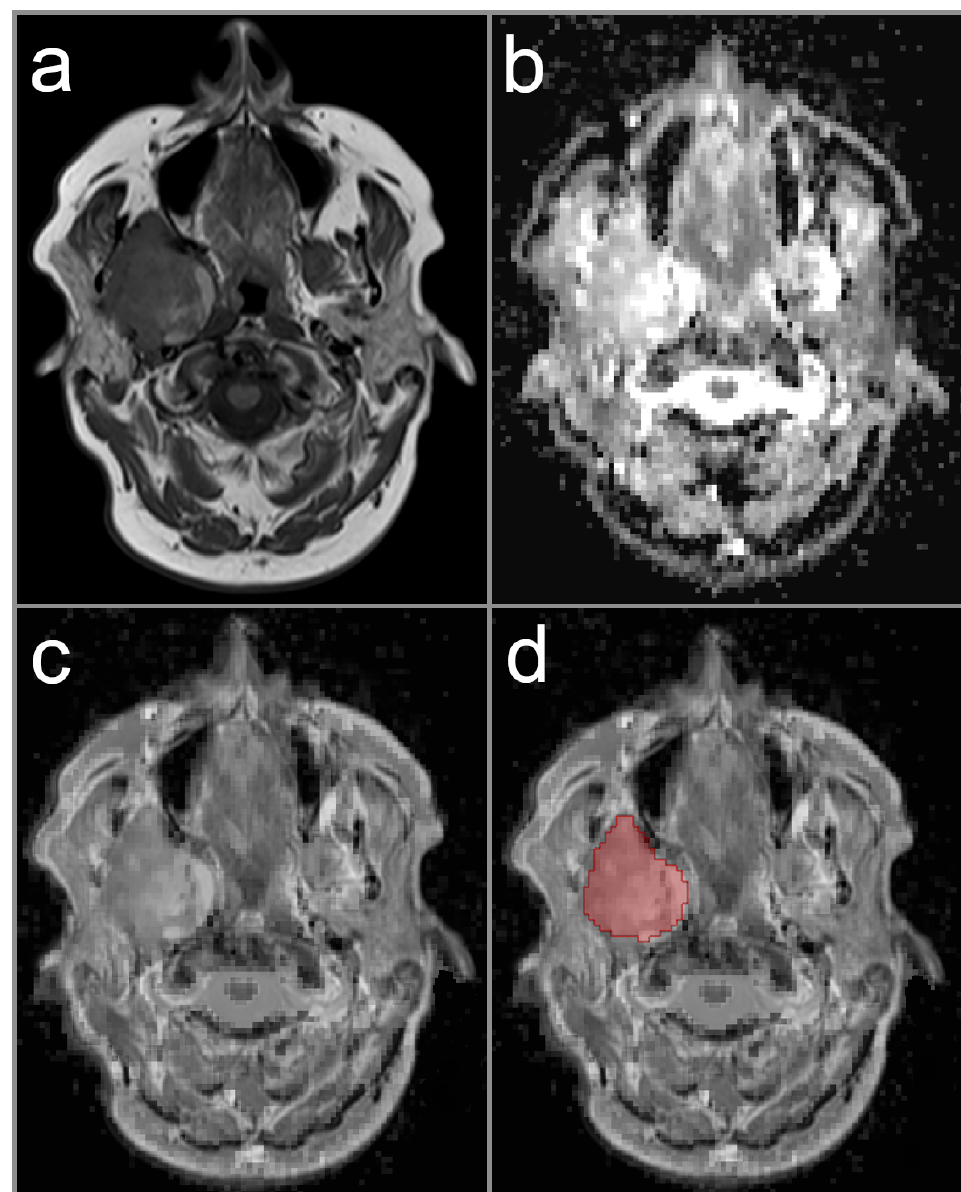
Figure 3. Image illustration a study patient with mucoepidermoid carcinoma in the deep lobe of the right parotid gland (red area indicates lesion on this particular slice). The image on the left upper row ( a ) shows native T1-weighted image with predominantly hypointense signal intensity of the parotid lesion. The image on the right upper row ( b ) represents the parametric ADC map. The image on the left lower row ( c ) shows the co-registration of the ADC map and T1-weighted image with a mix ratio of 50 %. The image on the right lower row ( d ) displays the co-registered image with the region-of-interest illustrated.